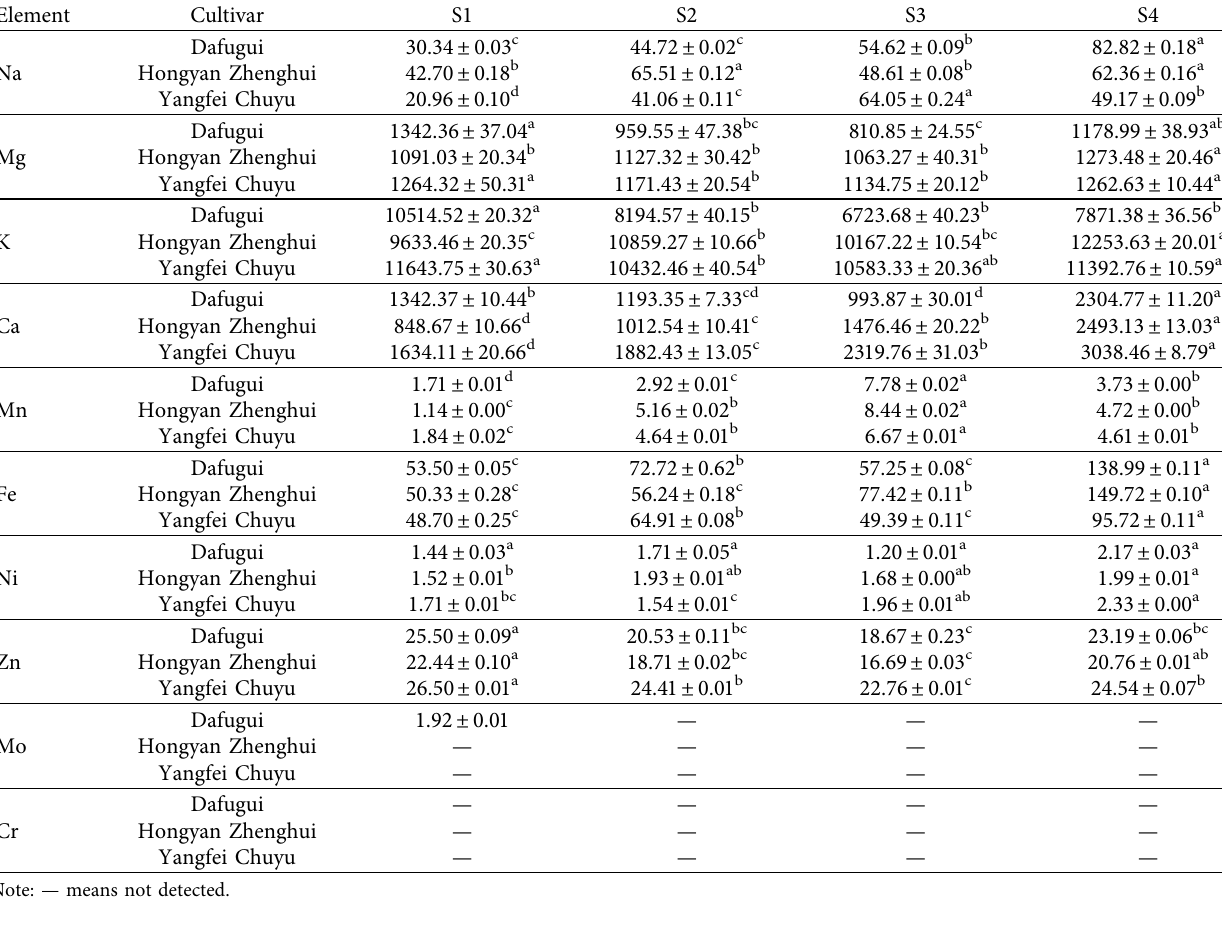
Table 1: The mineral elements content of developmental P. lactiflora petals ( μ g/g DW).